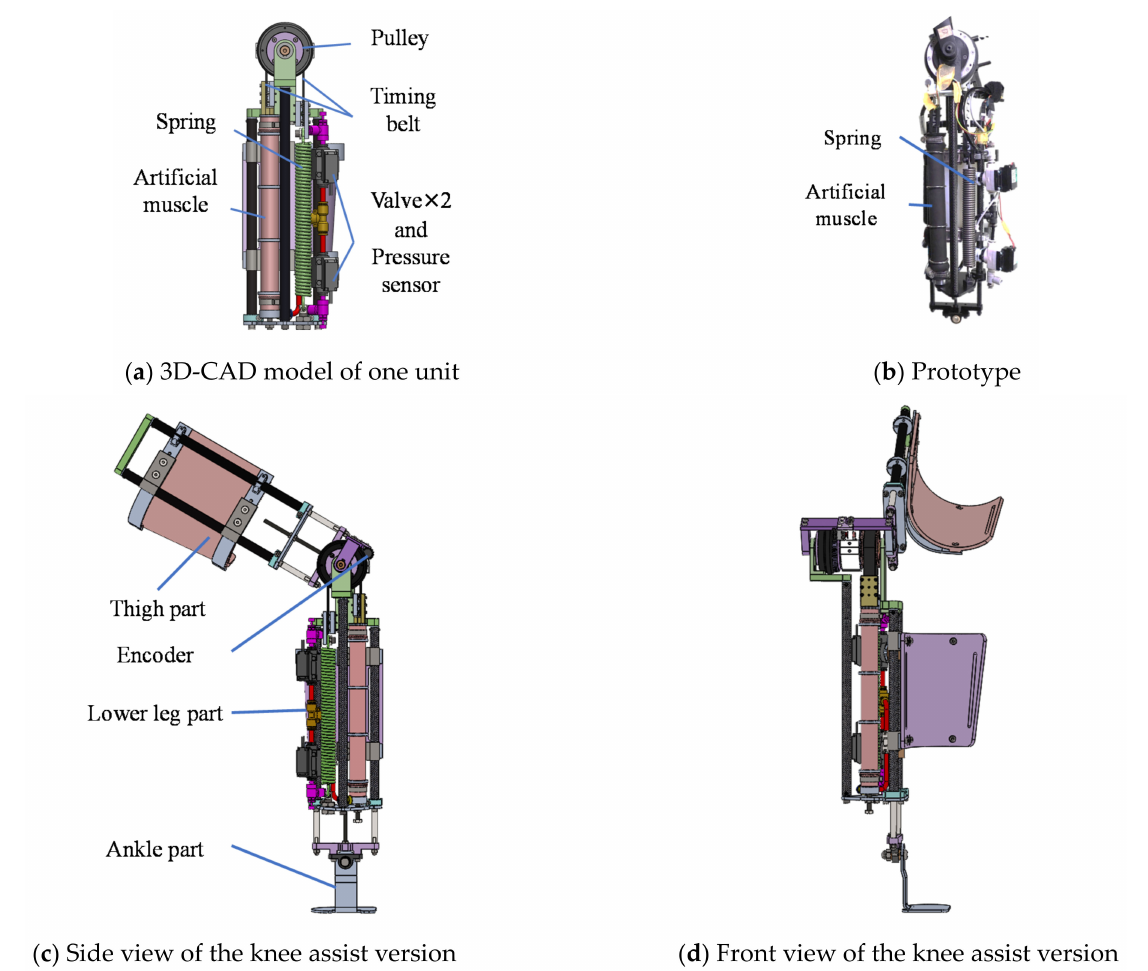
Figure 7. Prototype of the one-sided spring antagonized joint [20].